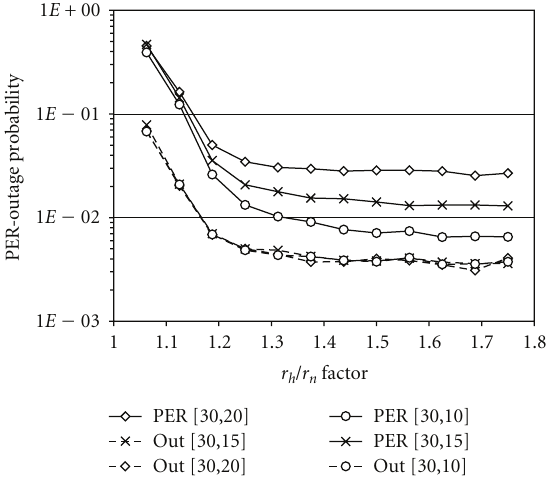
Figure 7: PER and outage probability (Out) versus r h filling rate, for a 30-packet codeword in urban Big Good state; in the legenda, the couple ( n, k ) indicates the codeword length ( n ) and the information block length ( k ),